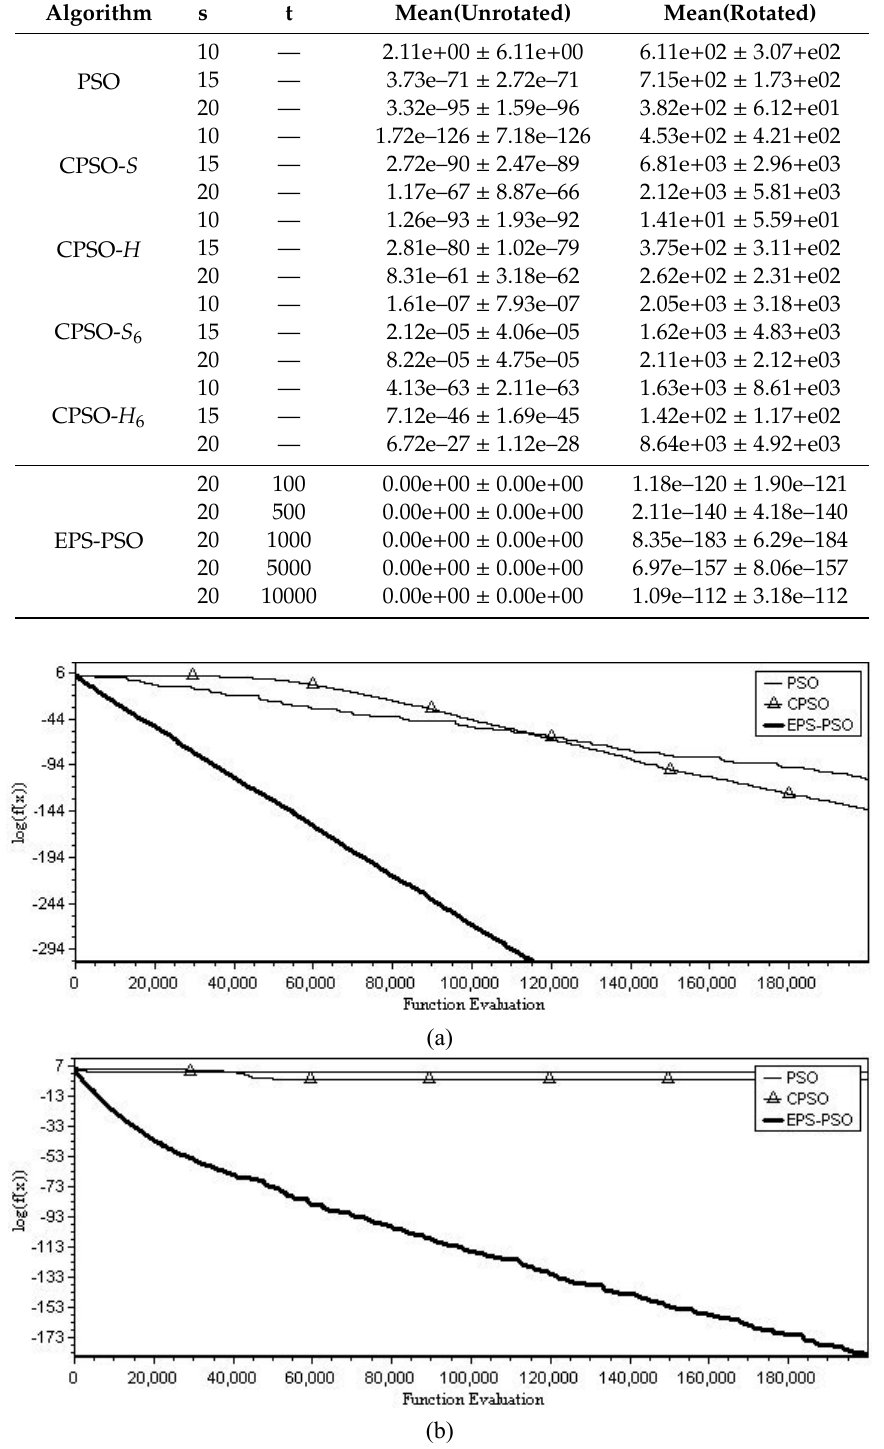
Figure 4. The best convergence results versus function evaluation among 50 independent runs for Quadric ( 2 f ): ( a ) unrotated case, ( b ) rotated case.